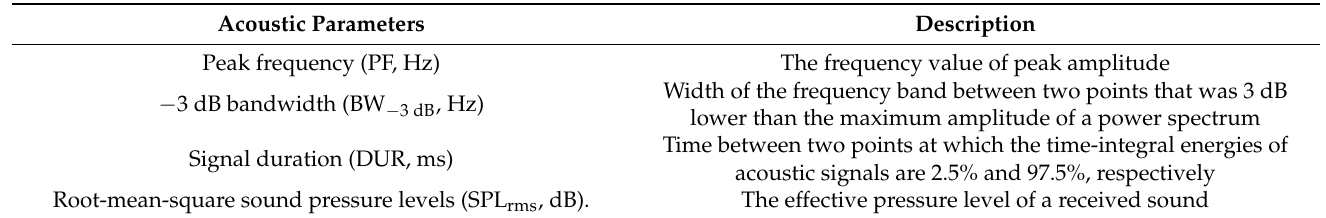
Table 1. Description of four acoustic parameters of Chinese bahaba calls.